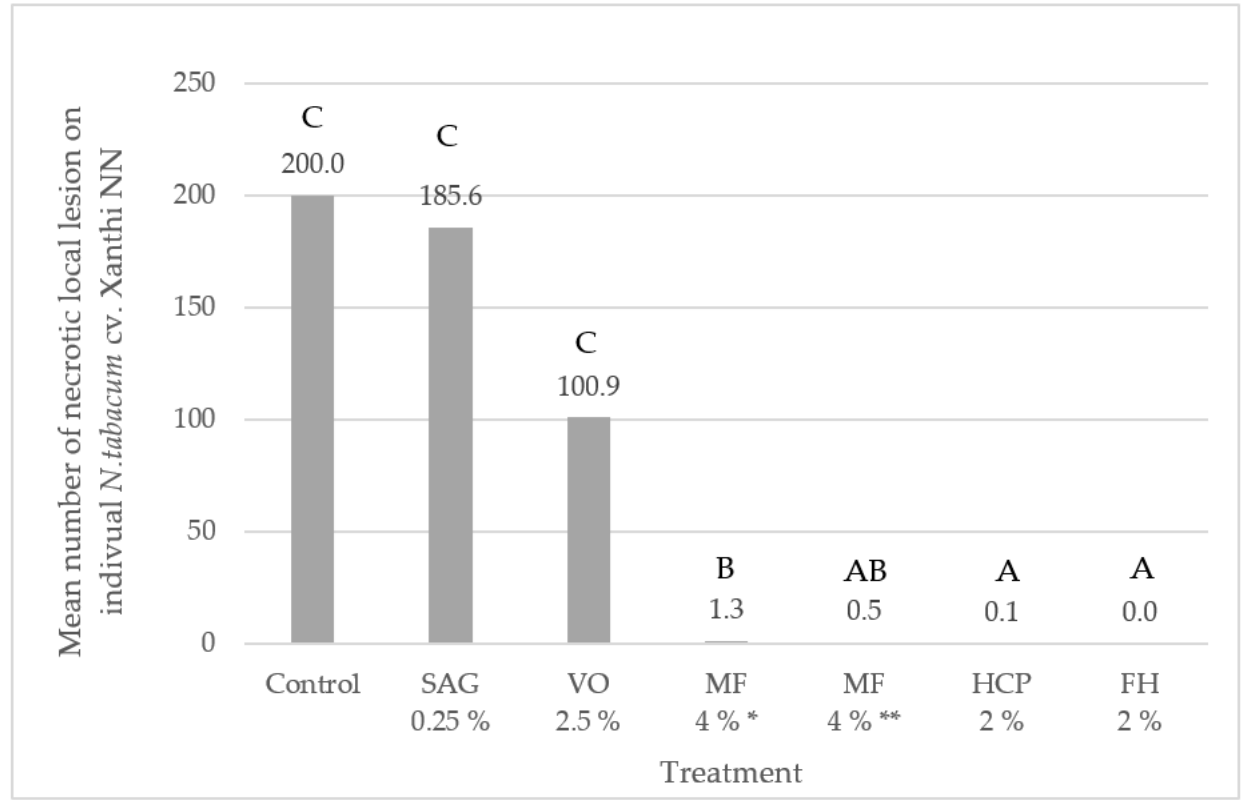
Figure 5. Evaluation of the residual infectivity of Tomato brown rugose fruit virus in the various cleaning solutions generated during the cleaning of ToBRFV-contaminated clothing by counting the number of necrotic local lesions on individual N. tabacum cv. Xanthi NN plants. Letters based on pairwise treatment comparisons using a generalized linear mixed model analysis of count data (alpha = 0.05, with Bonferroni correction). n = 24. ’Control’ = Deionized water with ToBRFV-contaminated fabric; ‘SAG’ = Spee Activ Gel; ‘VO’ = Vanish Oxi Action Gel; ‘MF’ = Menno Florades; ‘FH’ = Fadex H + ; ‘HCP’ = Hortisept Clean Plus. * 10 min contact time; ** 4 h contact time.